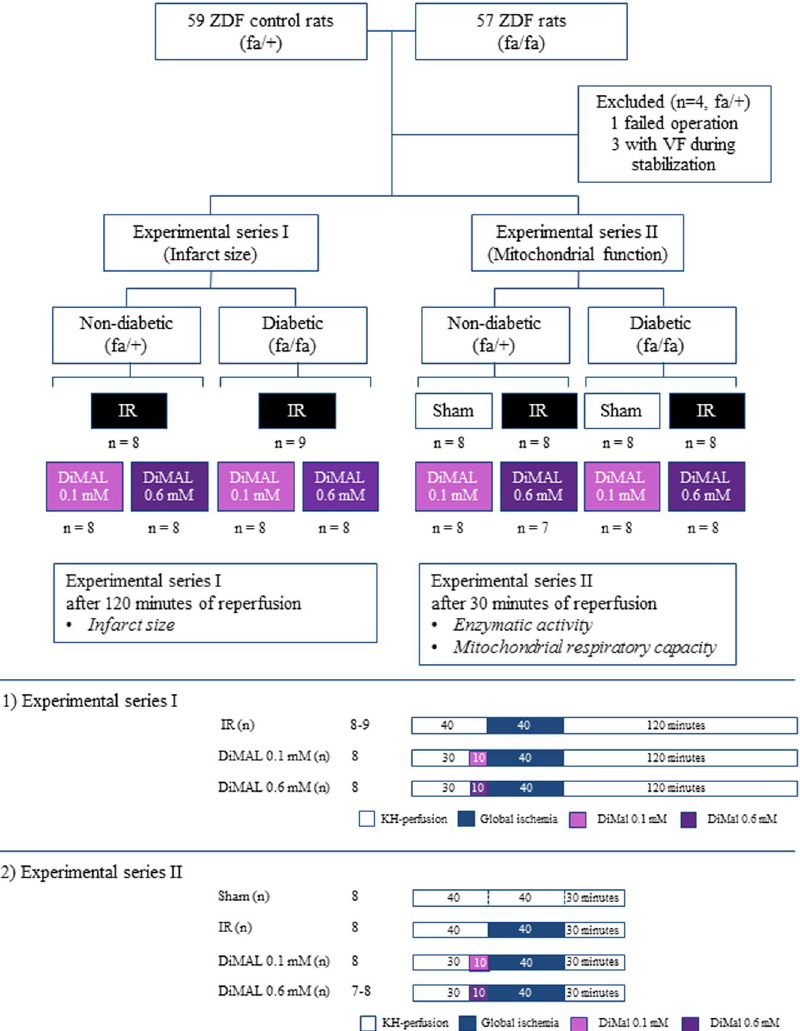
Figure 1. Study design of the isolated rat heart study. An overview of the two experimental series of the isolated rat heart study including subgroups and perfusion protocols. IR: Ischemia reperfusion, DiMAL: Dimethyl Malonate, VF: Ventricular